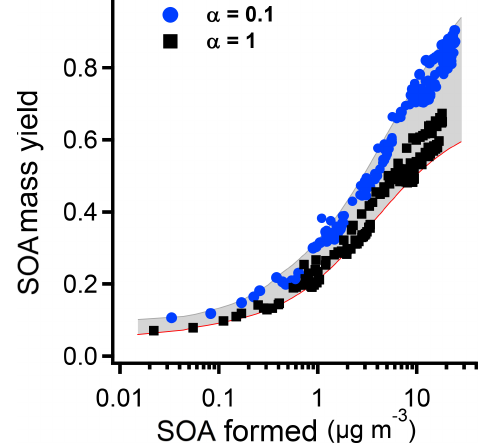
Figure 10. The summary of all the SOA mass yield after correcting both particle and vapor wall loss. The initial PD concentrations are 1, 2, 4, 5, and 6ppbv. The shaded area shows the yield range when α varies from 0.1 to 1.